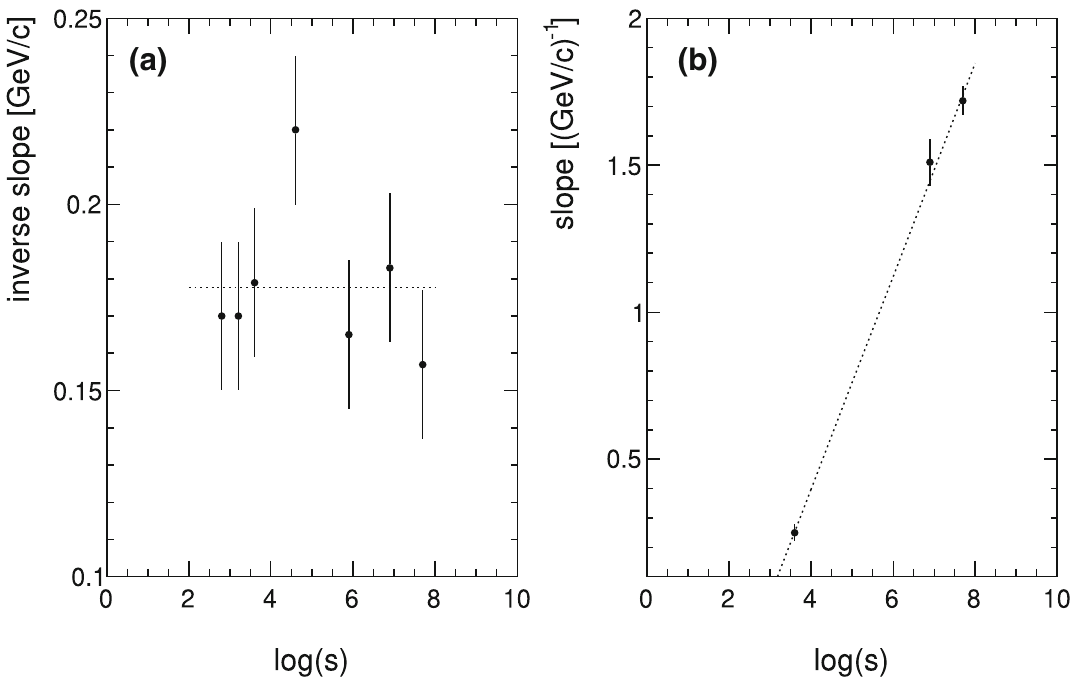
Fig. 126 Exponential fits to the cross section ratio (37) as given in Figs. 123, 124 and 125 a inverse slopes for the low p T region p T < 0.5 GeV/c and b slopes for the higher p T region at p T > 0.6 GeV/c